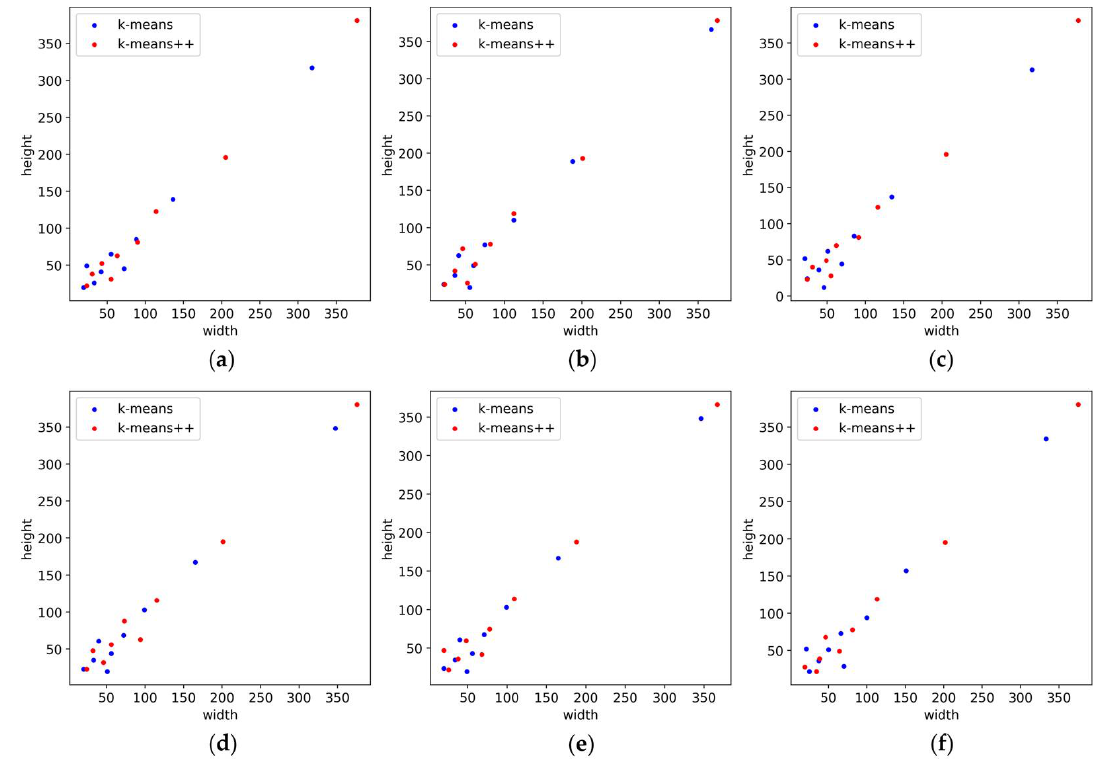
Figure 11. The visualization of the size distribution of six groups of a priori boxes: ( a ) Group 1; ( b ) Group 2; ( c ) Group 3; ( d ) Group 4; ( e ) Group 5; and ( f ) Group 6.